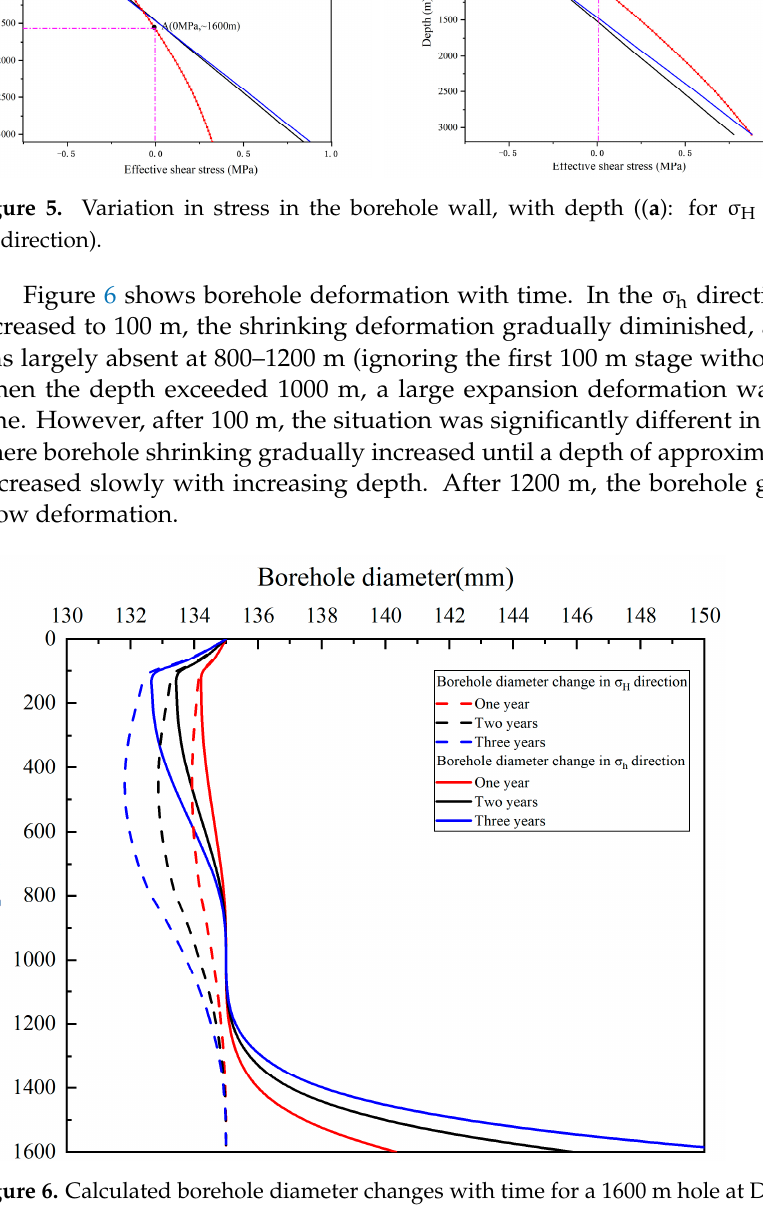
Figure 4. Calculated ice temperature distribution and variation in density with depth at Dome A.